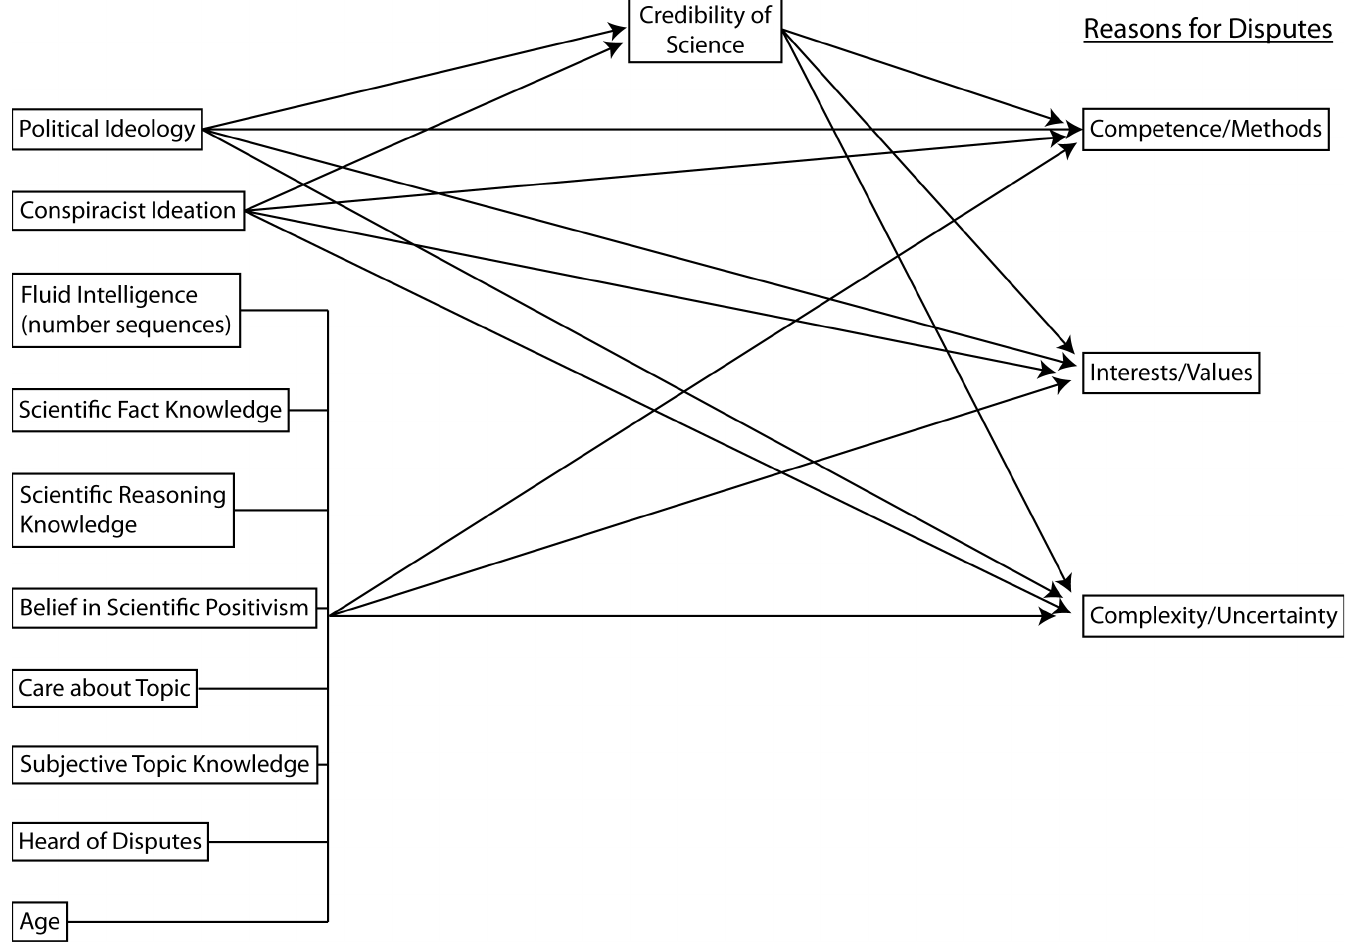
Fig 1. Study 2. Conceptual model tested for participants assigned to the salt and nanotechnology dispute scenarios.